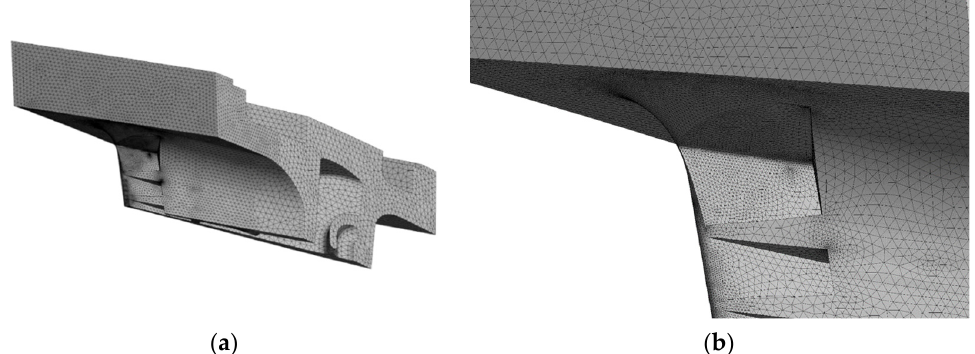
Figure 9. Mesh results: ( a ) refined mesh on sub-model; ( b ) mesh result around the PETE due to the sphere of influence.